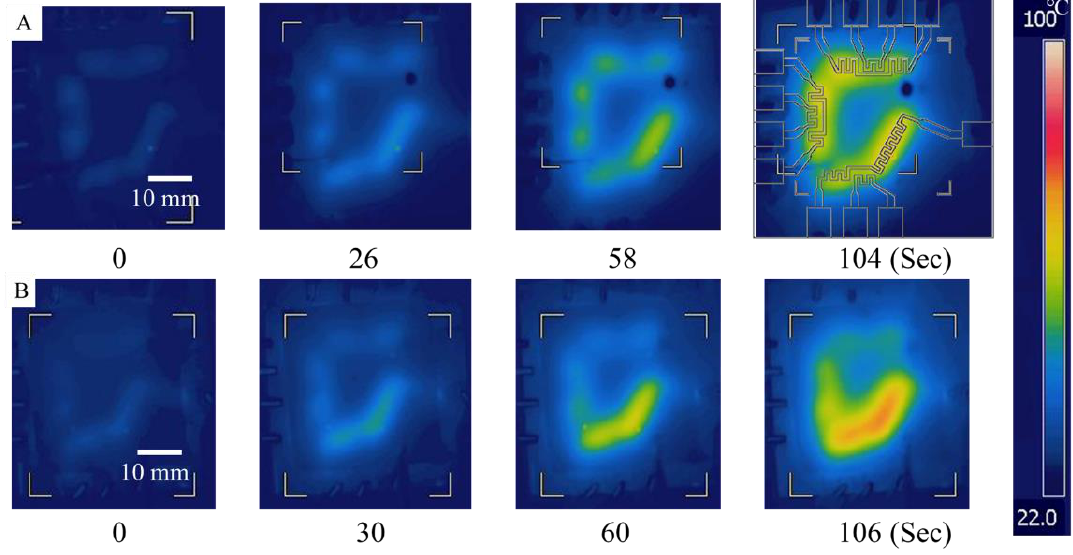
Figure 5. Temperature distribution while heating with on – chip microheater. ( A ) Heating process while sensors were set to one temperature; ( B ) heating process while sensors were set to different temperatures.